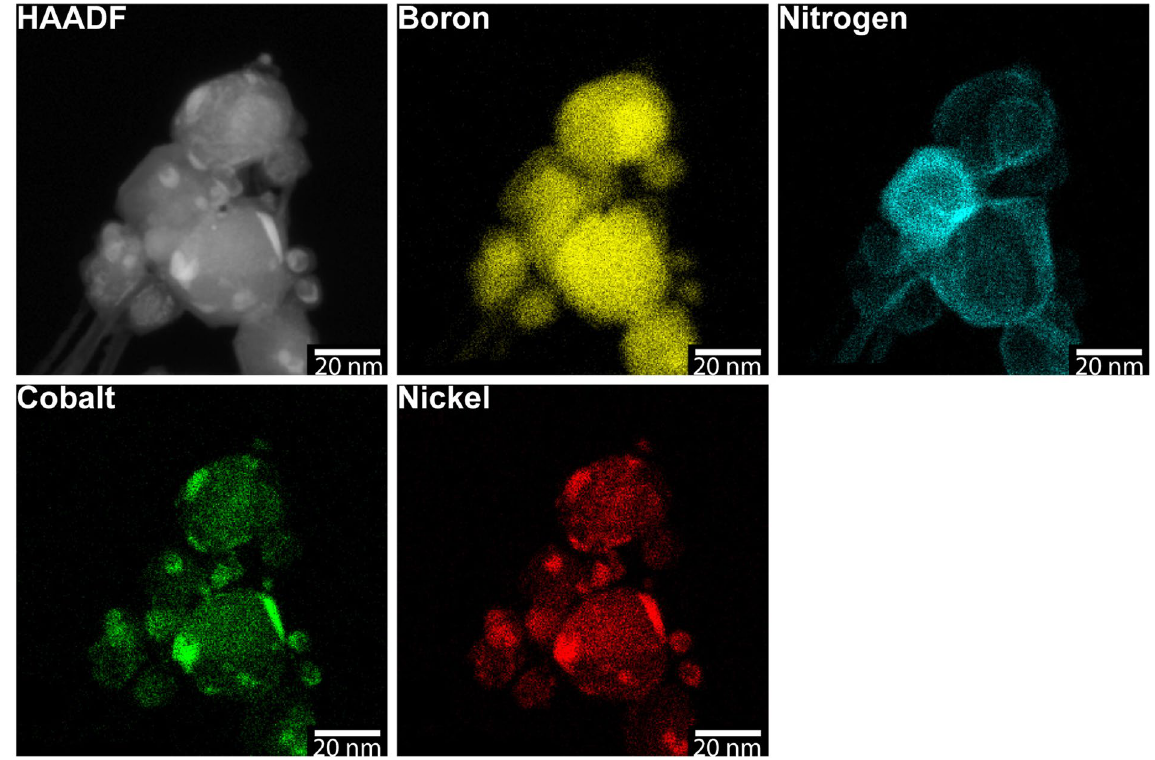
Figure 5. EDS elemental mapping results. The particles contain boron, cobalt, and nickel, characteristic of the starting anode material used in the arc synthesis. Boron and nitrogen mapping results show that the tube bundles on the lower left are boron nitride and the nanoparticles are wrapped by boron nitride.